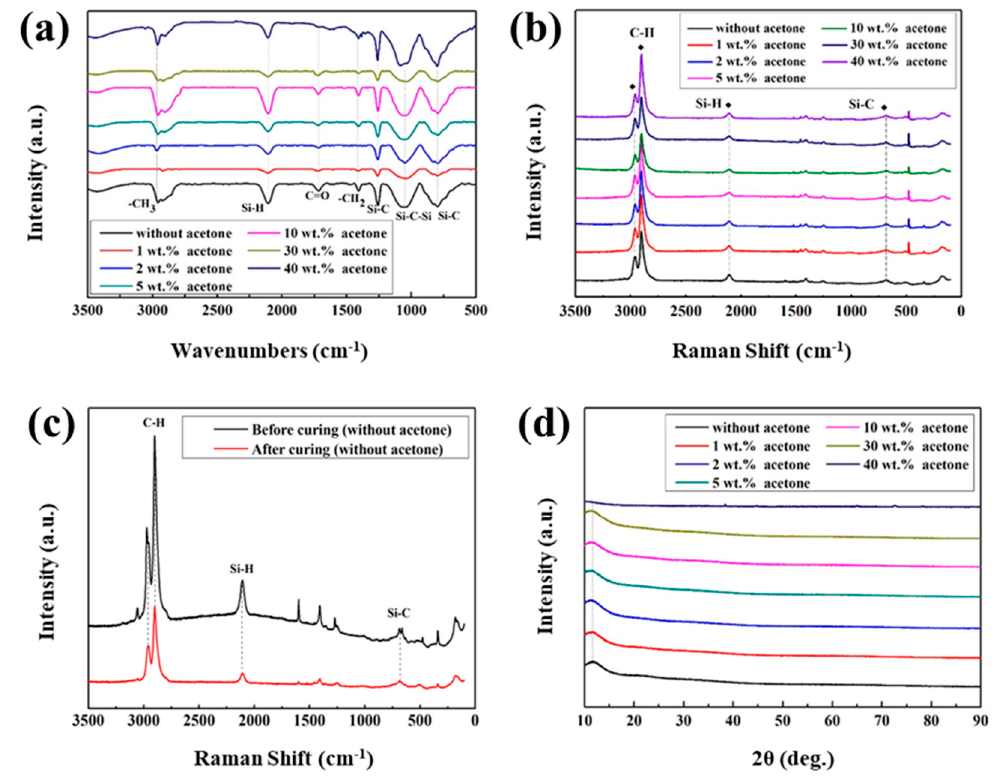
Figure 8. Raman spectra, FT-IR spectra, and X-ray diffraction (XRD) patterns. ( a ) FT-IR spectra after curing, ( b ) Raman spectra after curing, ( c ) Raman patterns before and after curing, and ( d ) XRD patterns with different acetone contents after curing.